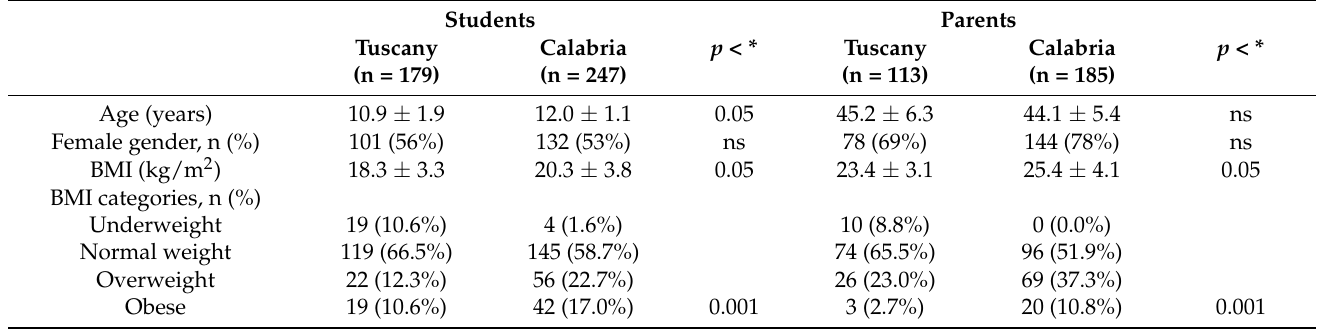
Table 1. Characteristics of students and parents according to geographical area of